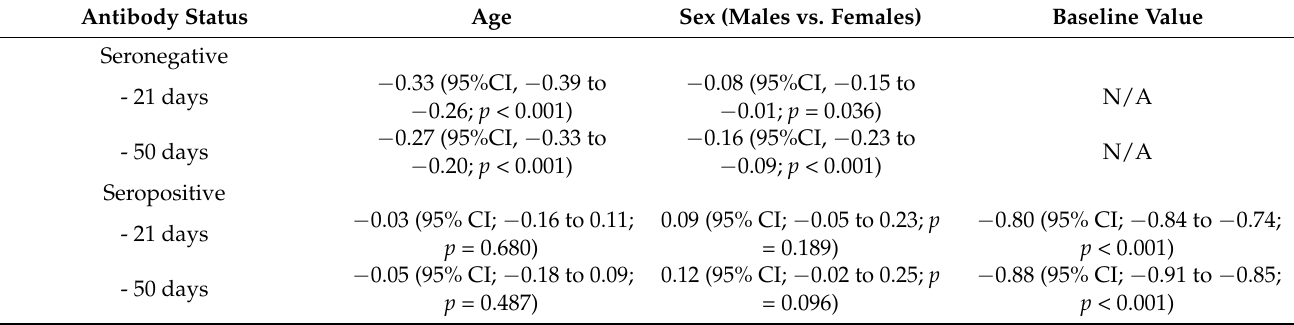
Table 2. Spearman’s correlation coefficient (and 95% CI) between the ratio of increase from individual baseline total anti- SARS-CoV-2 RBD antibodies level and age, sex or baseline antibodies value in baseline seronegative (<0.8 U/L) and baseline seropositive ( ≥ 0.8 U/L) subjects receiving a complete cycle (i.e., two doses) of Pfizer COVID-19 mRNA BNT162b2 vaccine.